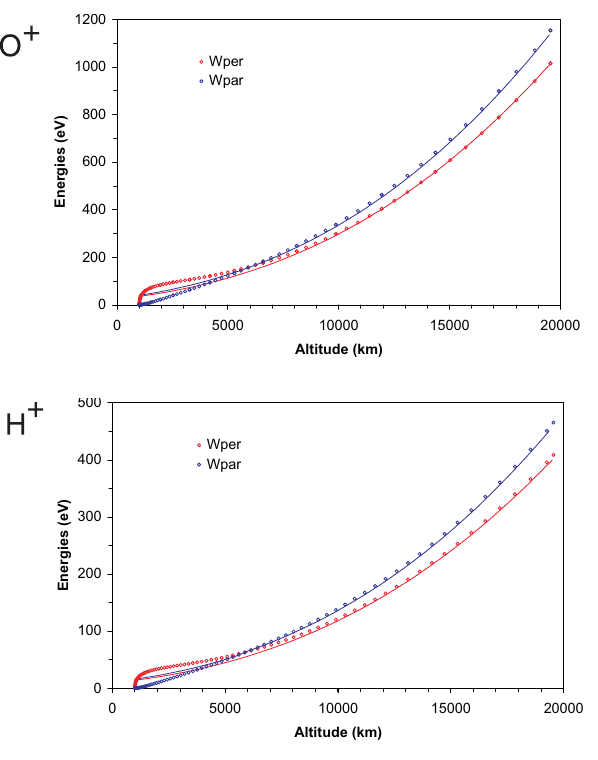
Fig. 5. Evolution of the integrated particle (left-hand side) and the energy density (right-hand side) fluxes of O + (top) and H + (bot- tom) ions. Red and blue curves correspond to the integrated fluxes over the poleward border ( X = 1) up to an altitude z , and over the horizontal extent of the heating region (0 < X < 1) at an al- titude z , respectively. The black curves correspond to the sum of all contributions and the dashed curve (right-hand side) denotes the transferred from the waves to particles below z . All quantities are normalized to the values at the low-altitude